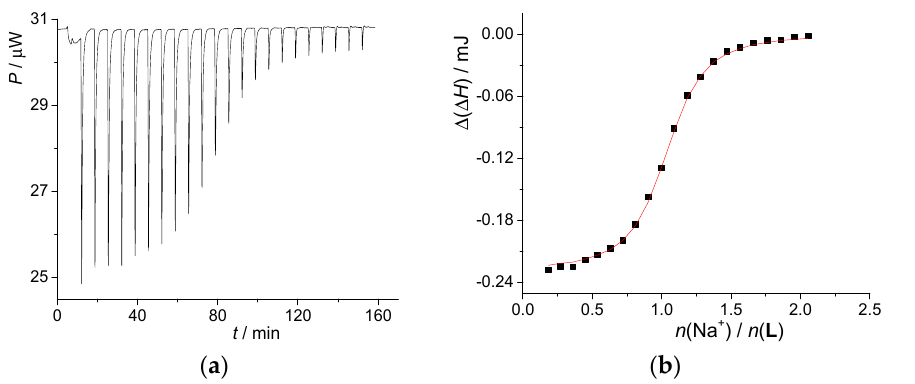
Figure 2. ( a ) Microcalorimetric titration of K L + ( c ( L ) = 1.22 × 10 − 4 mol dm –3 , c (KClO 4 ) = 1.91 × 10 − 3 mol dm –3 , V = 1.42 mL) with NaClO 4 ( c = 1.49 × 10 − 3 mol dm − 3 ) in methanol at 25 °C; ( b ) dependence of successive enthalpy change on n (NaClO 4 )/ n ( L ) ratio. ■ experimental; ― calculated.